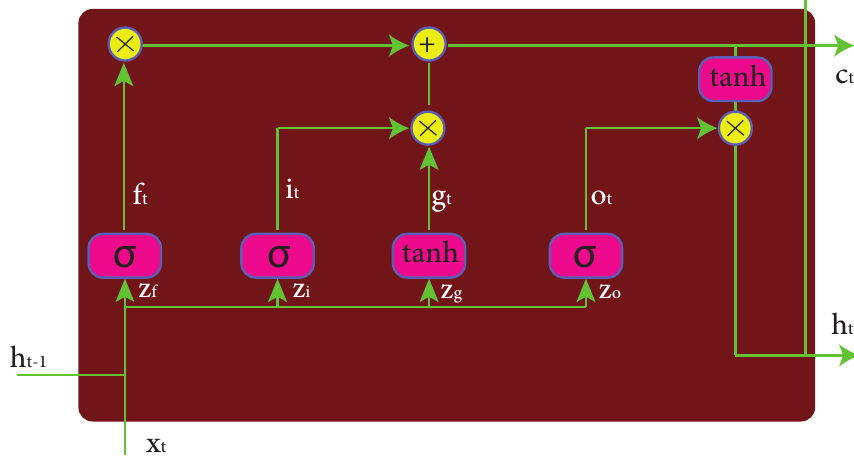
Figure 10. LSTM’s cell